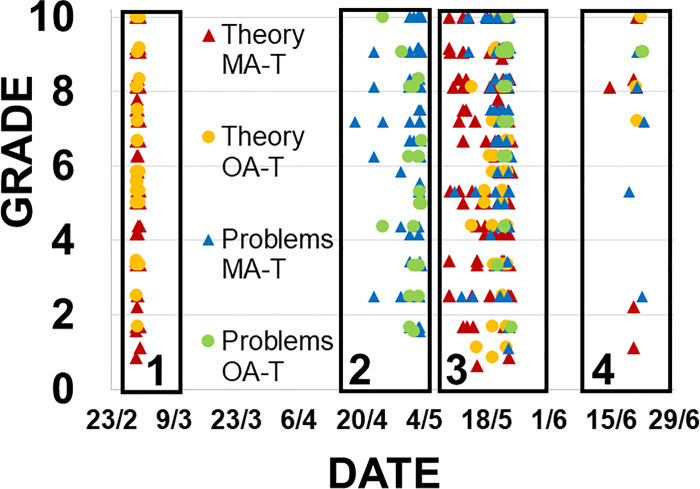
Distribution of attempts in the self-evaluation/learning phase in “Design of Water Treatment Facilities”.The horizontal axis corresponds to the dates and the vertical axis to the grades obtained in every individual attempt. The attempts made by all students in the 3 stages are presented.